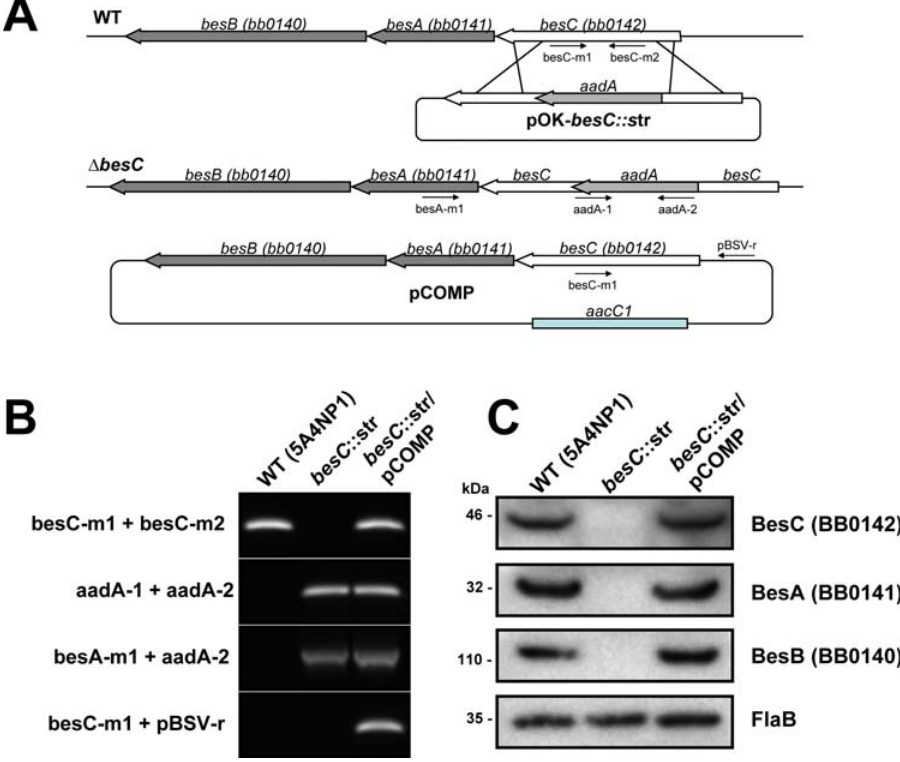
Figure 2. Characterization of the besC mutant strains. (A) Schematic representation of besC , becA and besB genes in the Borrelia burgdorferi B31 chromosome, insertion of the aadA gene cassette by homologous recombination and complementation plasmid. Arrows indicate the relative positions of the oligonucleotides used. The diagram is not drawn to scale. (B) PCR analysis of the wild-type strain, the resulting besC mutant and the complemented strain using primer pairs specific either only for the besC and aadA genes; or one primer specific for besA and the other for aadA gene. The PCR was also used to confirm the presence of the shuttle vector in the complemented strain using one primer specific for besC and another specific for the shuttle vector. (C) Immunoblotting using antiserum raised against BesA, BesB and BesC to determine the presence or absence of these proteins in wild-type, besC mutant and the complemented strain.